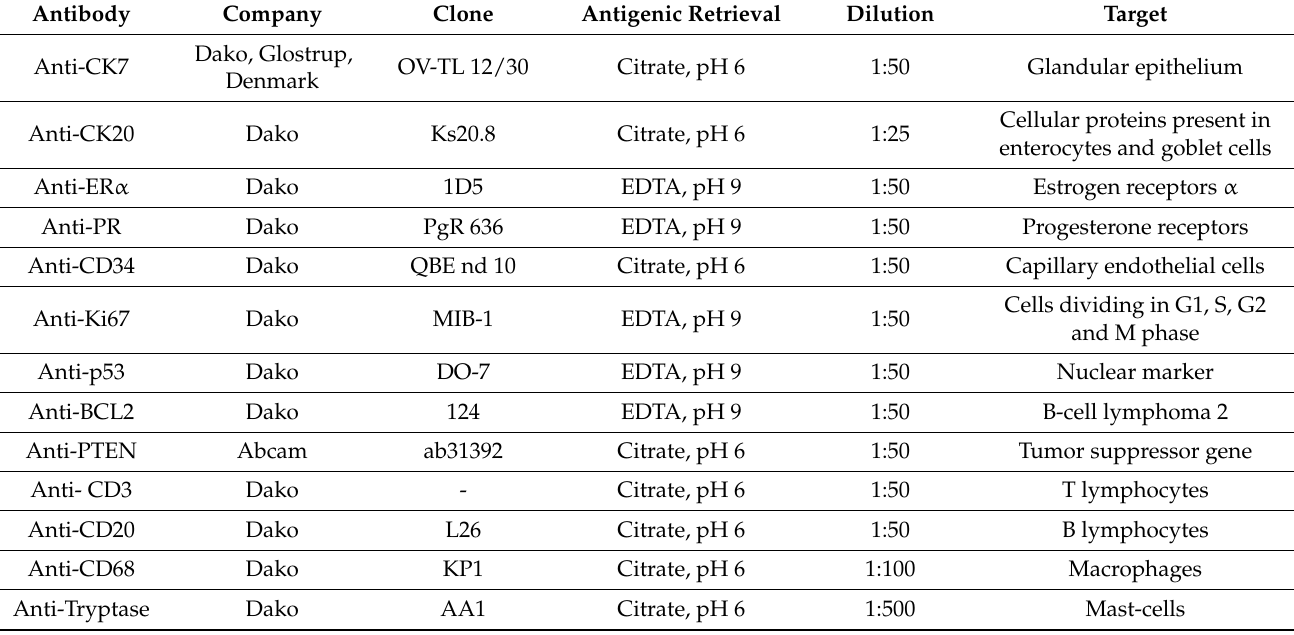
Table 1. Antibodies used in the immunohistochemical